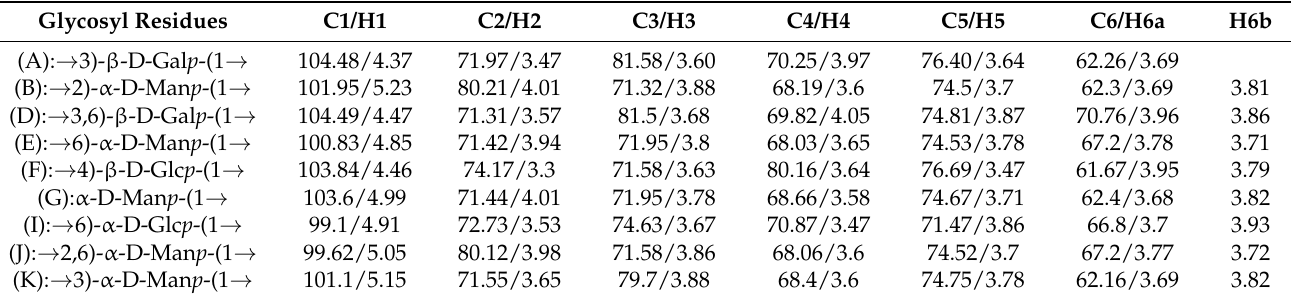
Figure 6. Morphological analysis of EPS2 − 1. ( A ) TEM images (12,000×, 20,000×, 40,000×); ( B ) AFM images of EPS2 − 1.